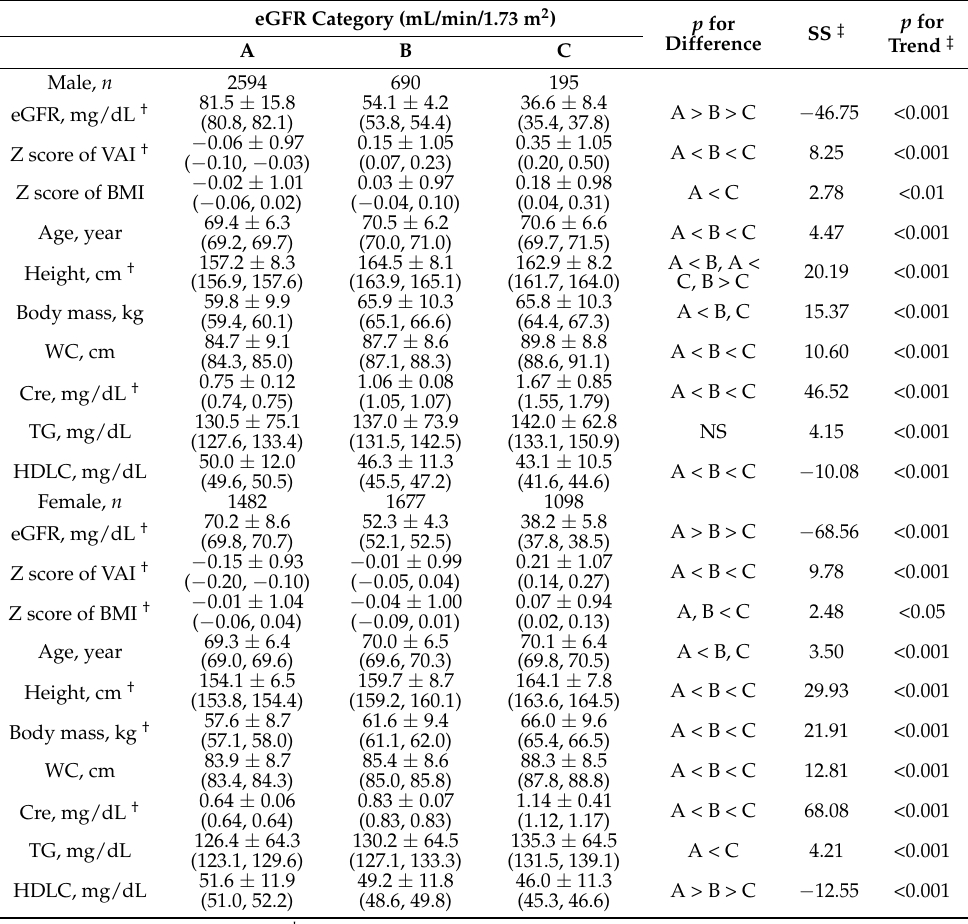
Table 2. Sex-specific differences, and trends of subjects by eGFR category. eGFR Category (mL/min/1.73 m 2